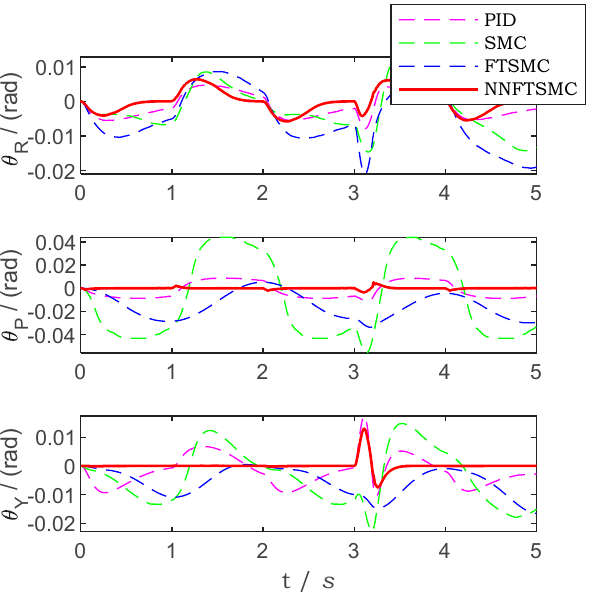
Figure 13. The trajectory tracking error by using different controllers in the simulation of attitude locking.